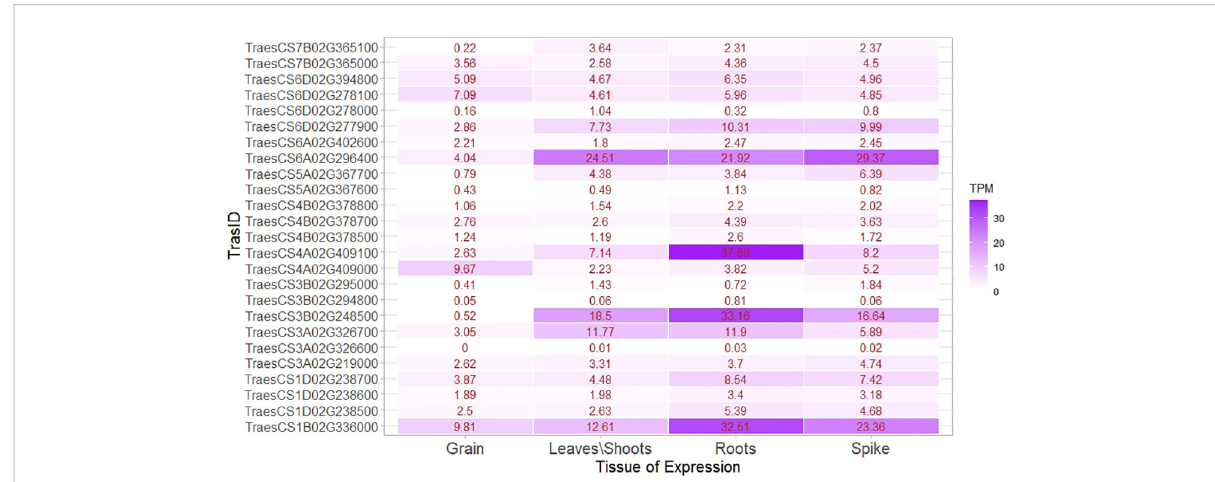
FIGURE 10 Expression heat map of identi fi ed genes in important tissues, that is, root, shoot/leaves, spikes, and